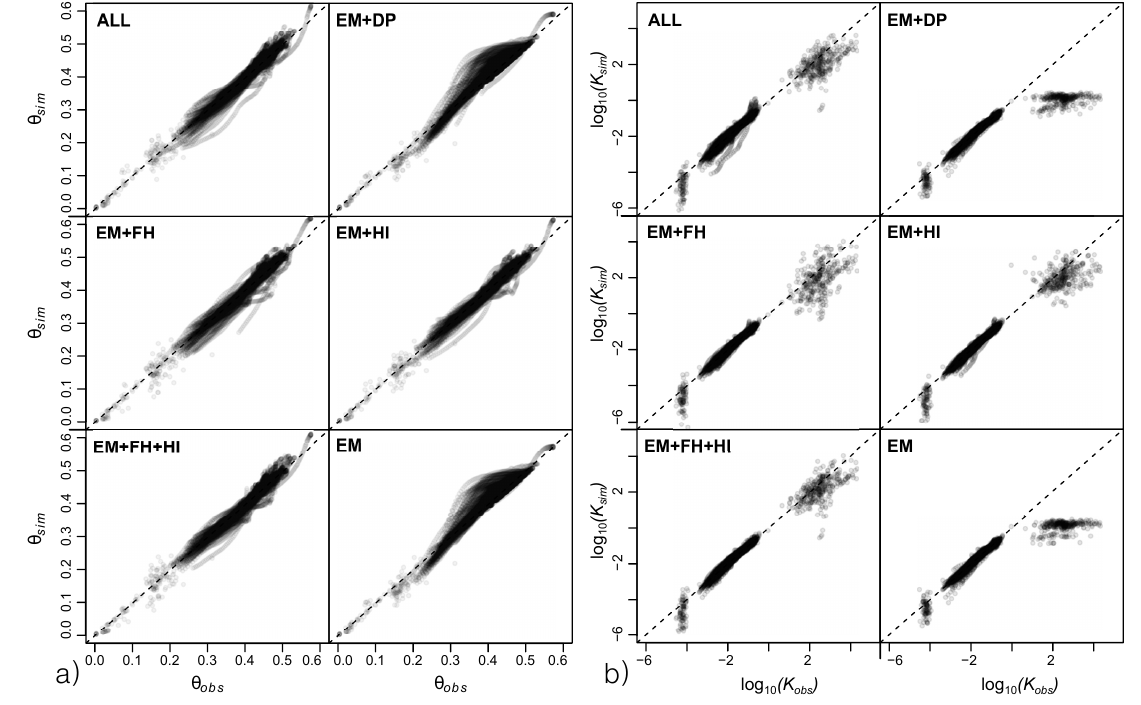
Figure 2. ( a ) comparison of volumetric water content θ ( h ) (cm 3 cm − 3 ) observed ( θ obs ) and calculated ( θ sim ) with fitted parameters; ( b ) comparison of hydraulic soil conductivity K ( h ) (log 10 (m day − 1 ) ) observed ( K obs ) and calculated ( K sim ) with fitted parameters; points are printed in semi-transparent black colour, hence dark parts show high point density; 88 samples included in each